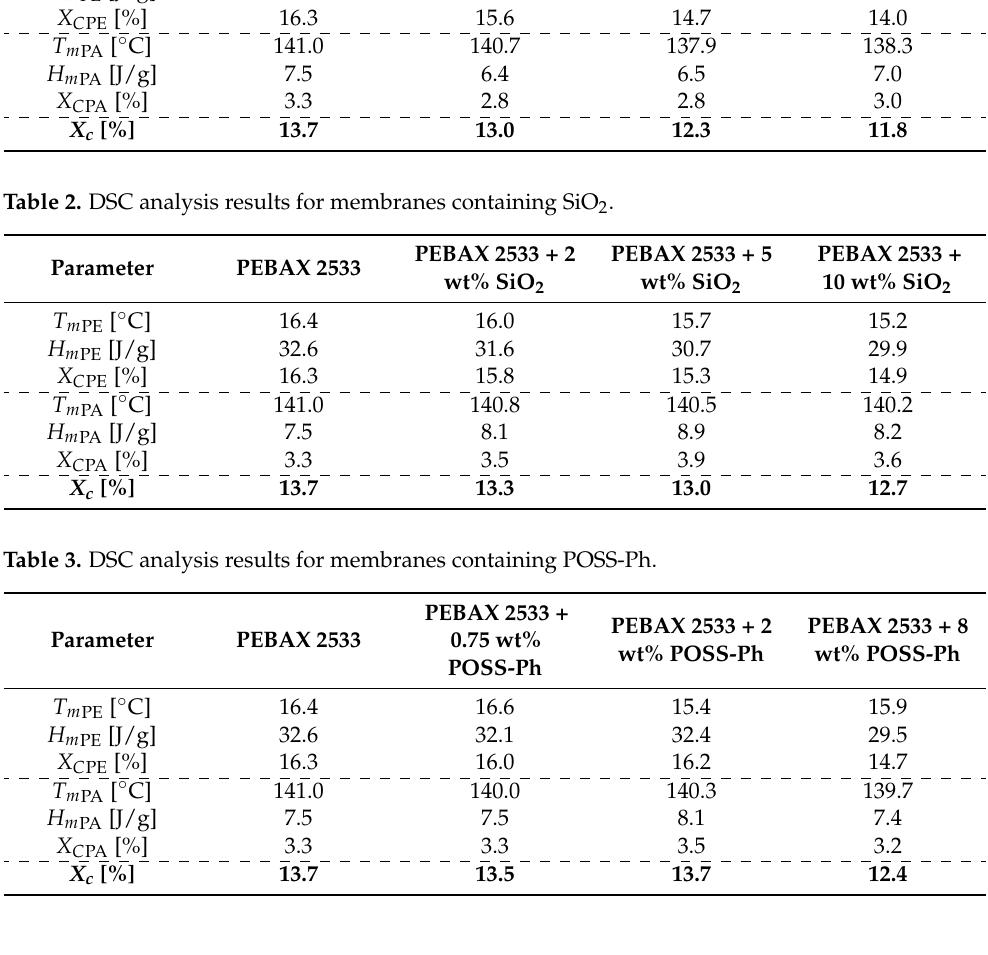
Table 4. Permeation coefficients P i of the test gases for membranes of different ZIF-8 concentrations.